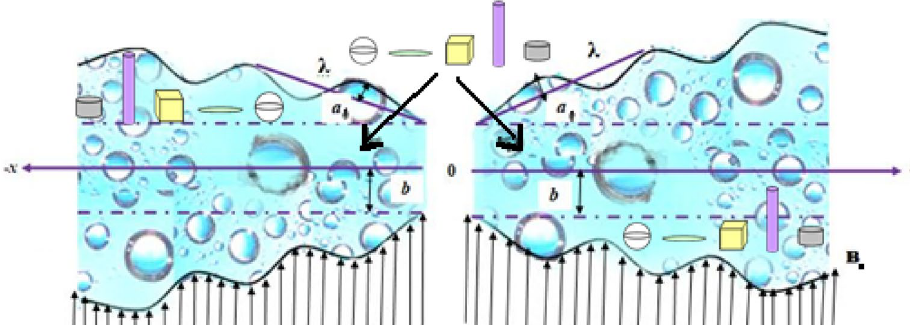
Figure 1. Geometry of the divergent-convergent